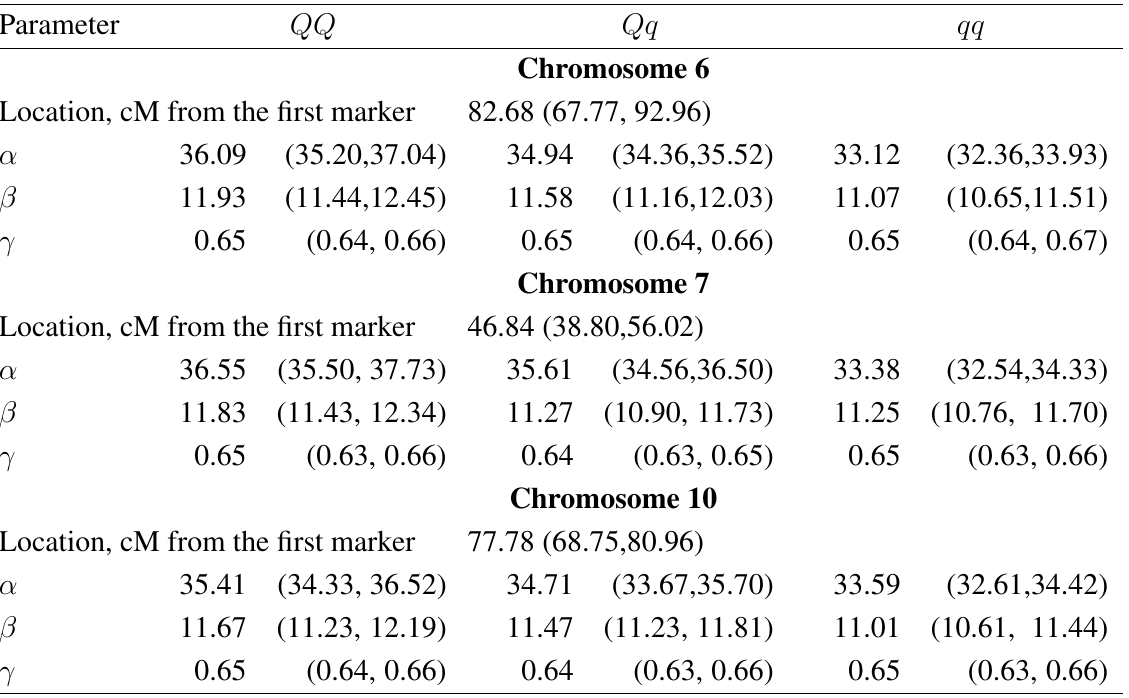
Table 1. Bayesian estimates of QTL locations and genotype-specific growth curves for the QTLs detected on mouse chromosome 6, 7 and 10. Numbers in parentheses are the 95% equal-tail confidence intervals.